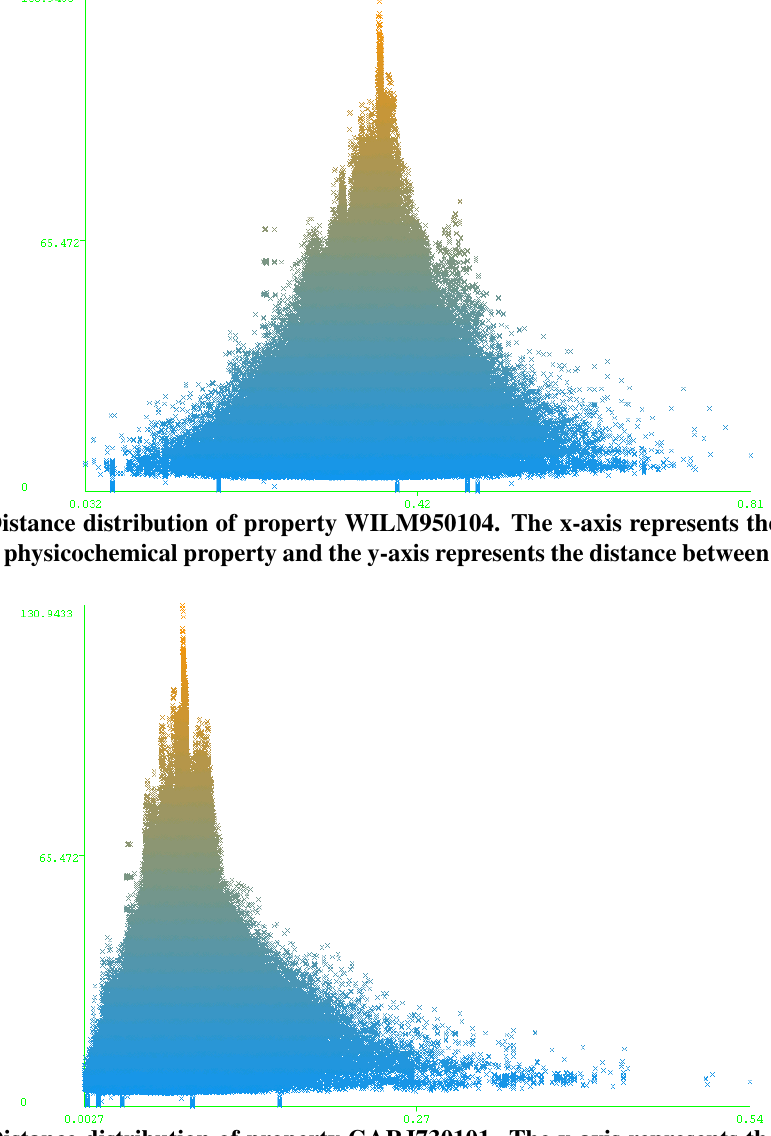
Figure 4: Distance distribution of property GARJ730101. The x-axis represents the normalized value of the physicochemical property and the y-axis represents the distance between amino